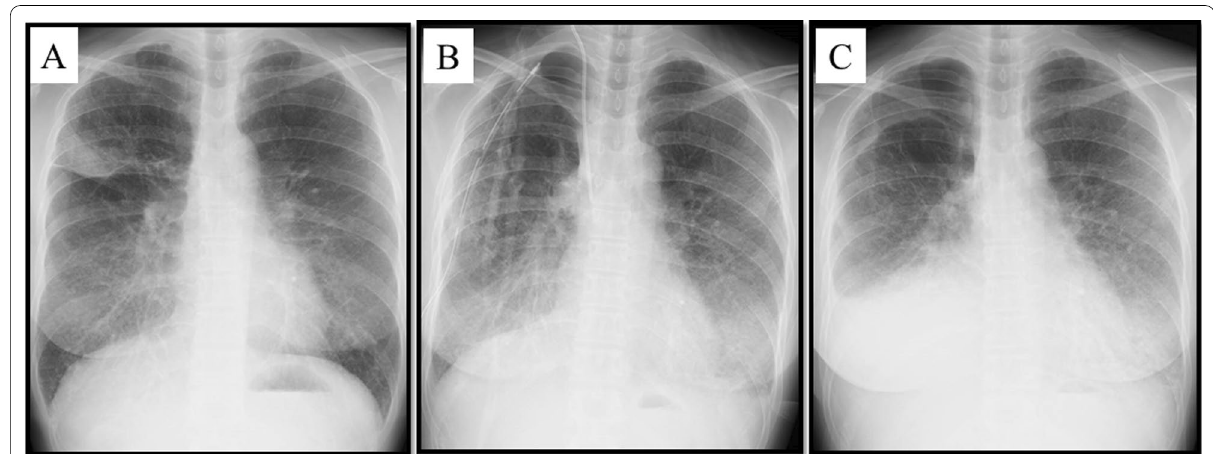
Fig. 1 Chest radiograph findings of complications after thoracic surgery in a representative LAM patient (Case 1 in Table 2). a Preoperative chest radiograph shows aspergilloma in the right upper lung field. b Chest radiography findings 2 days after right upper lobectomy. A drain was inserted into the right thoracic cavity, and a central venous catheter inserted in the right internal jugular vein. Both are visible in the right lung field. This figure shows decreased radiolucency in bilateral lungs and pleural effusion on the opposite side of the surgery. c A chest radiograph 14 days after surgery shows that pulmonary congestion and pleural effusion are getting